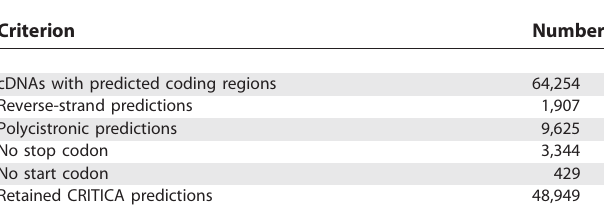
Table 1. Initial Filtering of CRITICA CDS Predictions for